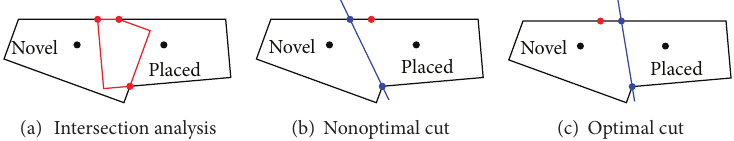
Figure 3: Shared cut. If both cuts satisfy the aforementioned constraints, cut (c) is chosen. In this way a smaller area is removed from the novel tile.